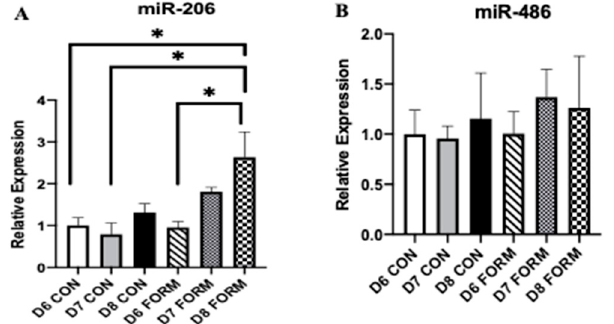
Figure 4. For each figure (n = 5), the symbol (*) is used to represent a significance difference between conditions. miR-206 ( A ): D8 FORM was increased compared to D6 CON ( p = 0.011); D8 FORM was increased compared to D7 CON ( p = 0.003); D8 FORM was increased compared to D6 FORM ( p = 0.009). miR-486 ( B ): There were no changes in expression between conditions.